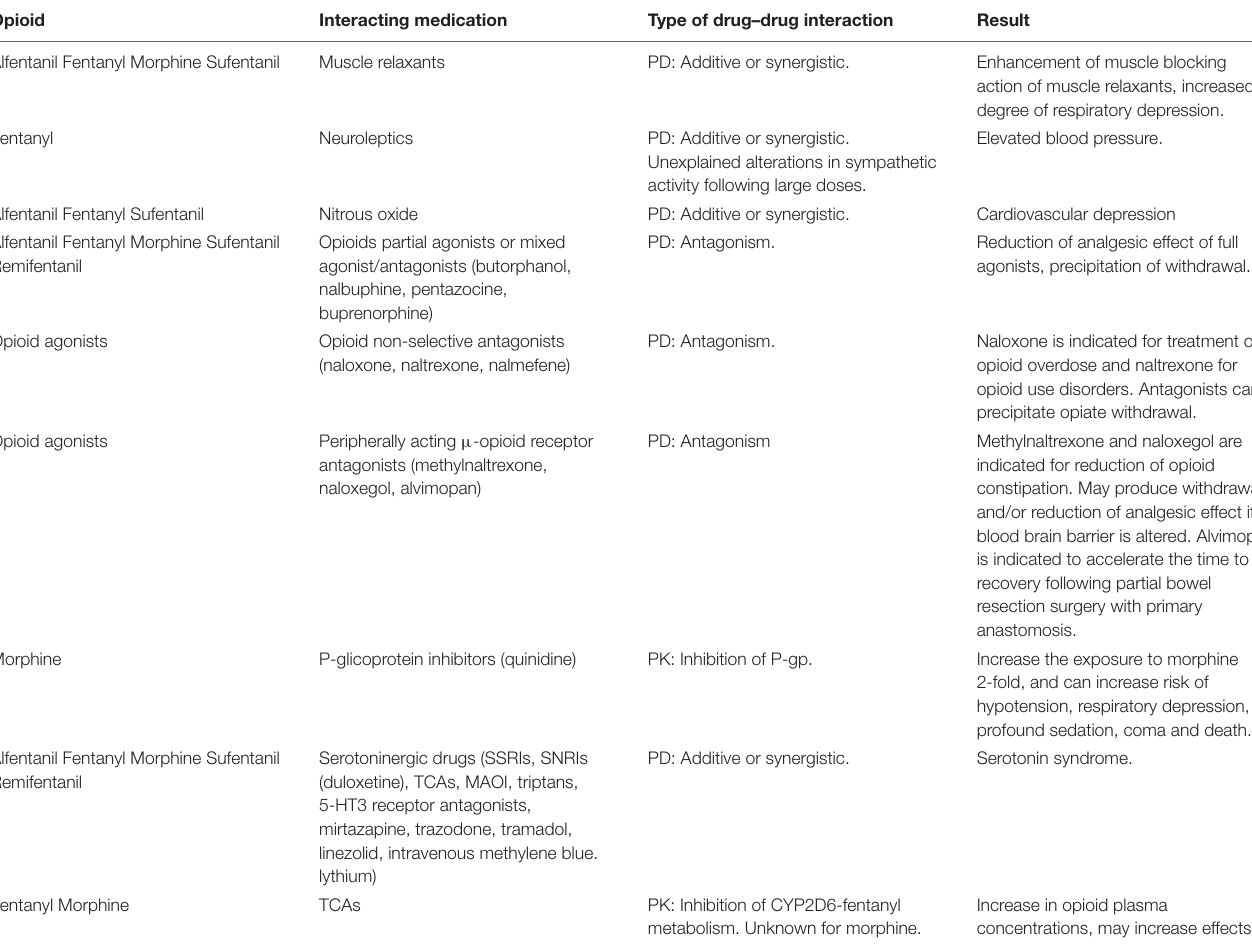
TABLE 2 | Drug–drug interactions with morphine, fentanyl and other pharmaceutical analogs (Mozayani and Raymon, 2004; Baxter, 2008; Preston, 2015; Karalliedde et al., 2016; European Medicines Agency [EMA], 2018; Food and Drug Administration [FDA], 2018). Opioid Interacting medication Type of drug–drug